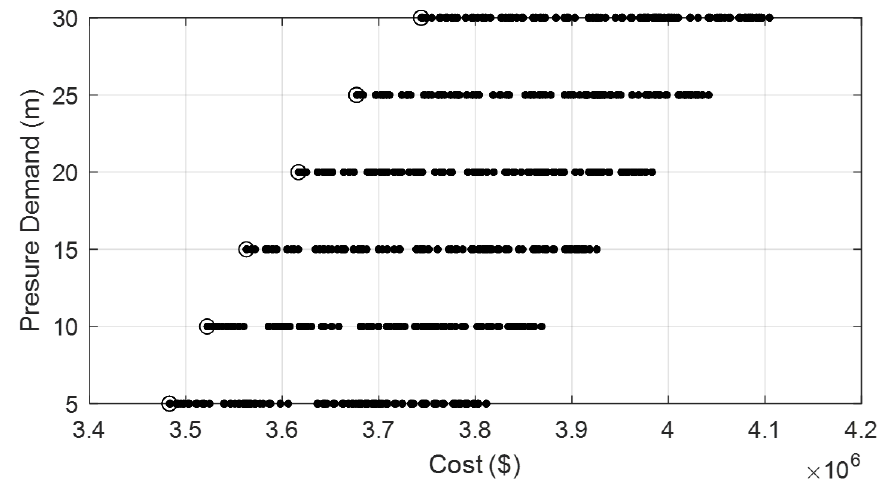
Figure 2. Cost vs. minimum pressure demand for FOWM network.